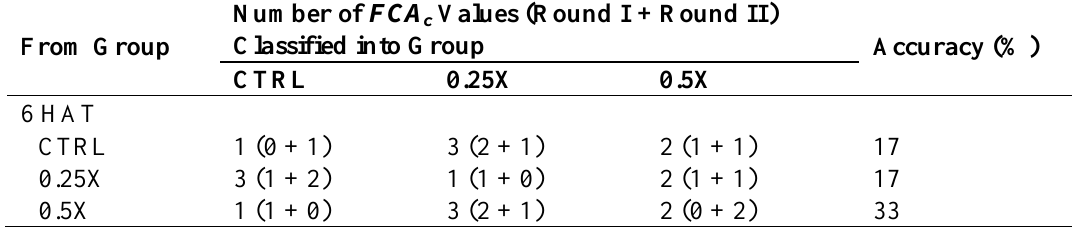
Table 11. Linear discriminant analysis with a two-fold cross validation schema for FCA values of cotton